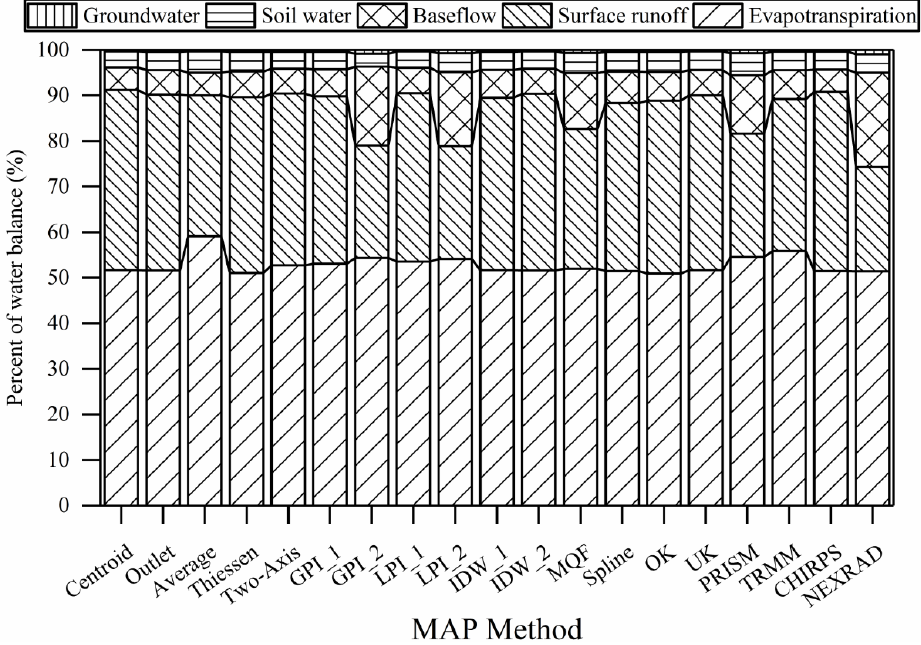
Figure 5. Mean areal precipitation (MAP) input effects on the water balance variables (mm) after SWAT model calibration in the Hinkson Creek Watershed, Missouri, USA. SWAT models were forced with 19 different precipitation methods. Ground water is deep aquifer recharge.